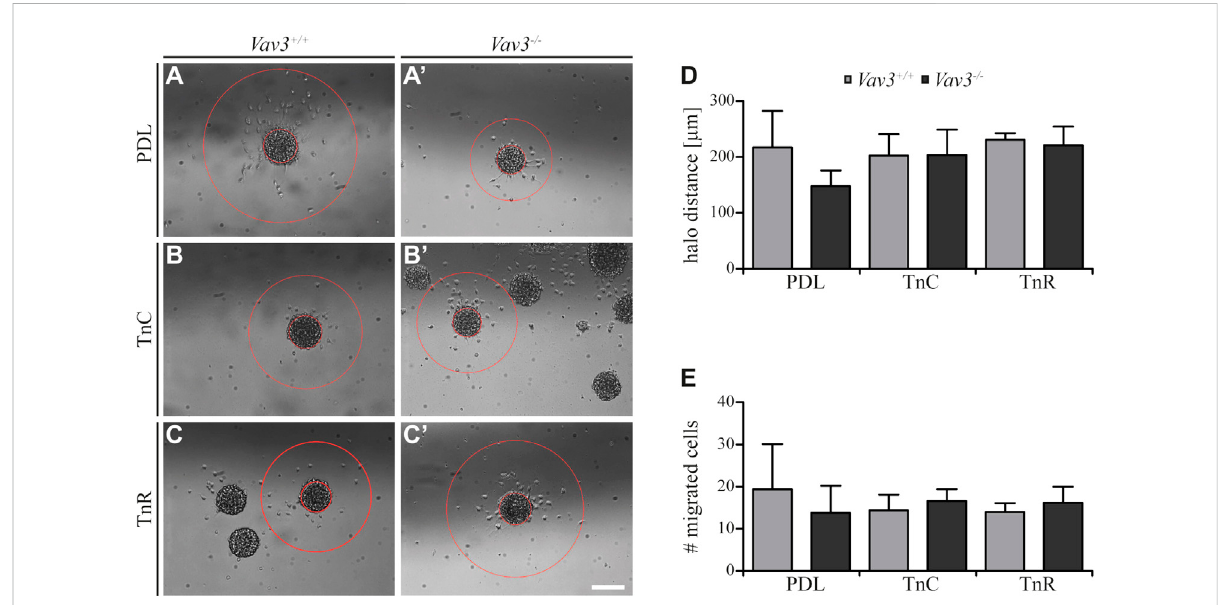
FIGURE 5 Migration of OPCs from oligospheres on PDL and tenascins. (A + A 9 ) Vav3-expressing ( Vav3 +/+ ) and Vav3-de fi cient ( Vav3 − / − ) oligospheres on PDL after 24 h of migration. (B + B 9 ) Migration success of OPCs from oligospheres of either genotype on tenascin-C (TnC) after 24 h. (C + C 9 ) Migration success of OPCs from Vav3 +/+ and Vav3 − / − oligospheres on tenascin-R (TnR) after 24 h. (D) The quanti fi cation of halo distance [in µm] revealed that OPCs on tenascins covered similar distances as OPCs on PDL. (E) The quanti fi cation of total cell numbers (#) migrating on